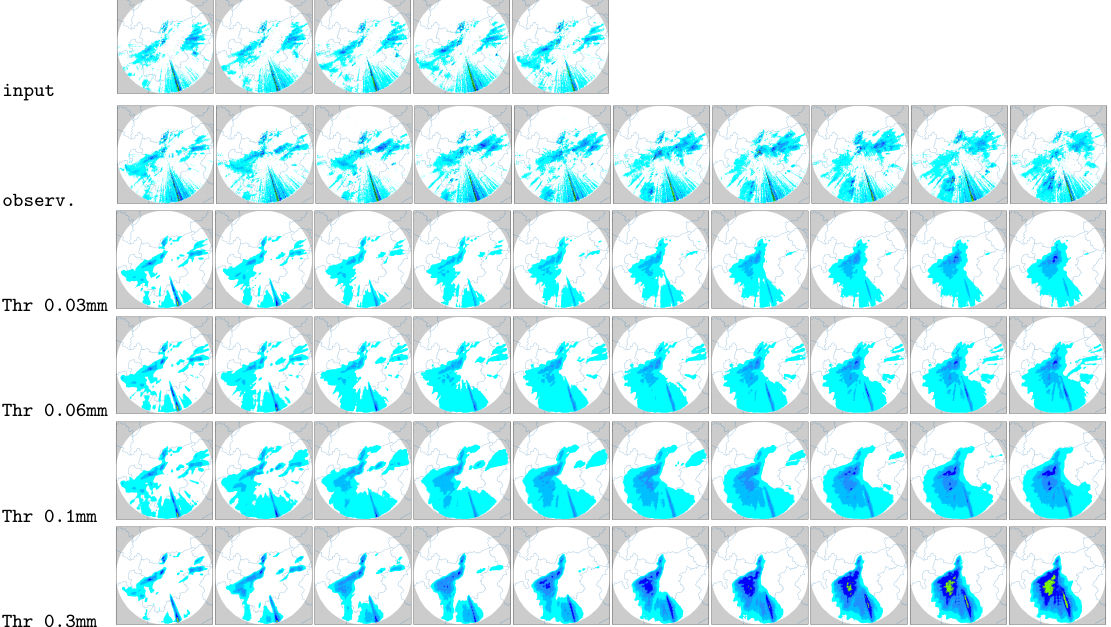
Figure 5. Ensemble prediction with TRE valid at 00:20 UTC 26 April 2017 (best viewed in color). The first row shows the five input scans (25 min), while the subsequent rows show the observation (ground truth) and the four models’ output. Observation and prediction are sub-sampled one every two images (10 min) to improve representation clarity. The ensemble spread can be observed when rising the threshold